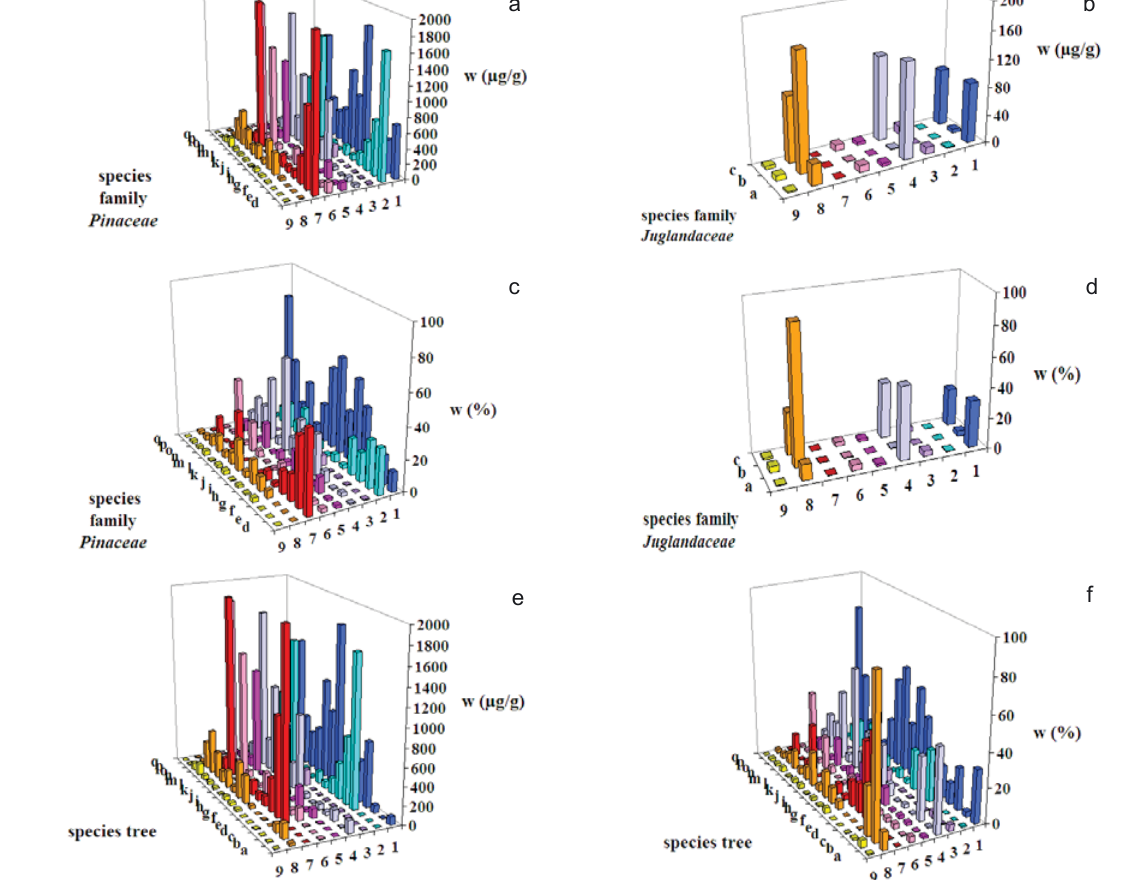
Figure 6. The effect of species tree on the amount (a, b, e) and representation (c, d, f) of terpenes in tree family Pinaceae and Juglandaceae, Individual terpenes: 1 - (+)- a -pinene, 2 - (-)-camphene, 3 – sabinene, 4 - (-)- b -pinene, 5 – myrcene, 6 - R-(+)-limonene, 7 - (-)-bornylacetate, 8 - (-)- trans -caryophyllene, 9 - a -humulene, species family Pinaceae and Juglandaceae : a - Juglans regia , b - J. nigra c - J. sieboldiana var. Cordiformis , e - Picea abies , f - P. pungens , g - P. Breweriana , h - Pinus nigra , i - P. mungo turra , j - P. black , k - P. sylvestris , l - Abies pinsapo , m - A. holophylla , n - A. Bronmuelleris , o - A. alba , p - Larix Kaempferi , q - L.